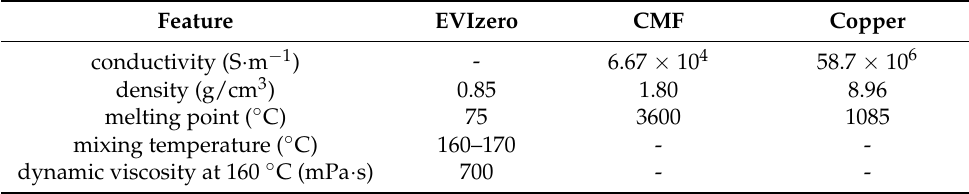
Table 1. Material characteristics for EVIzero [44], CMF [45] and